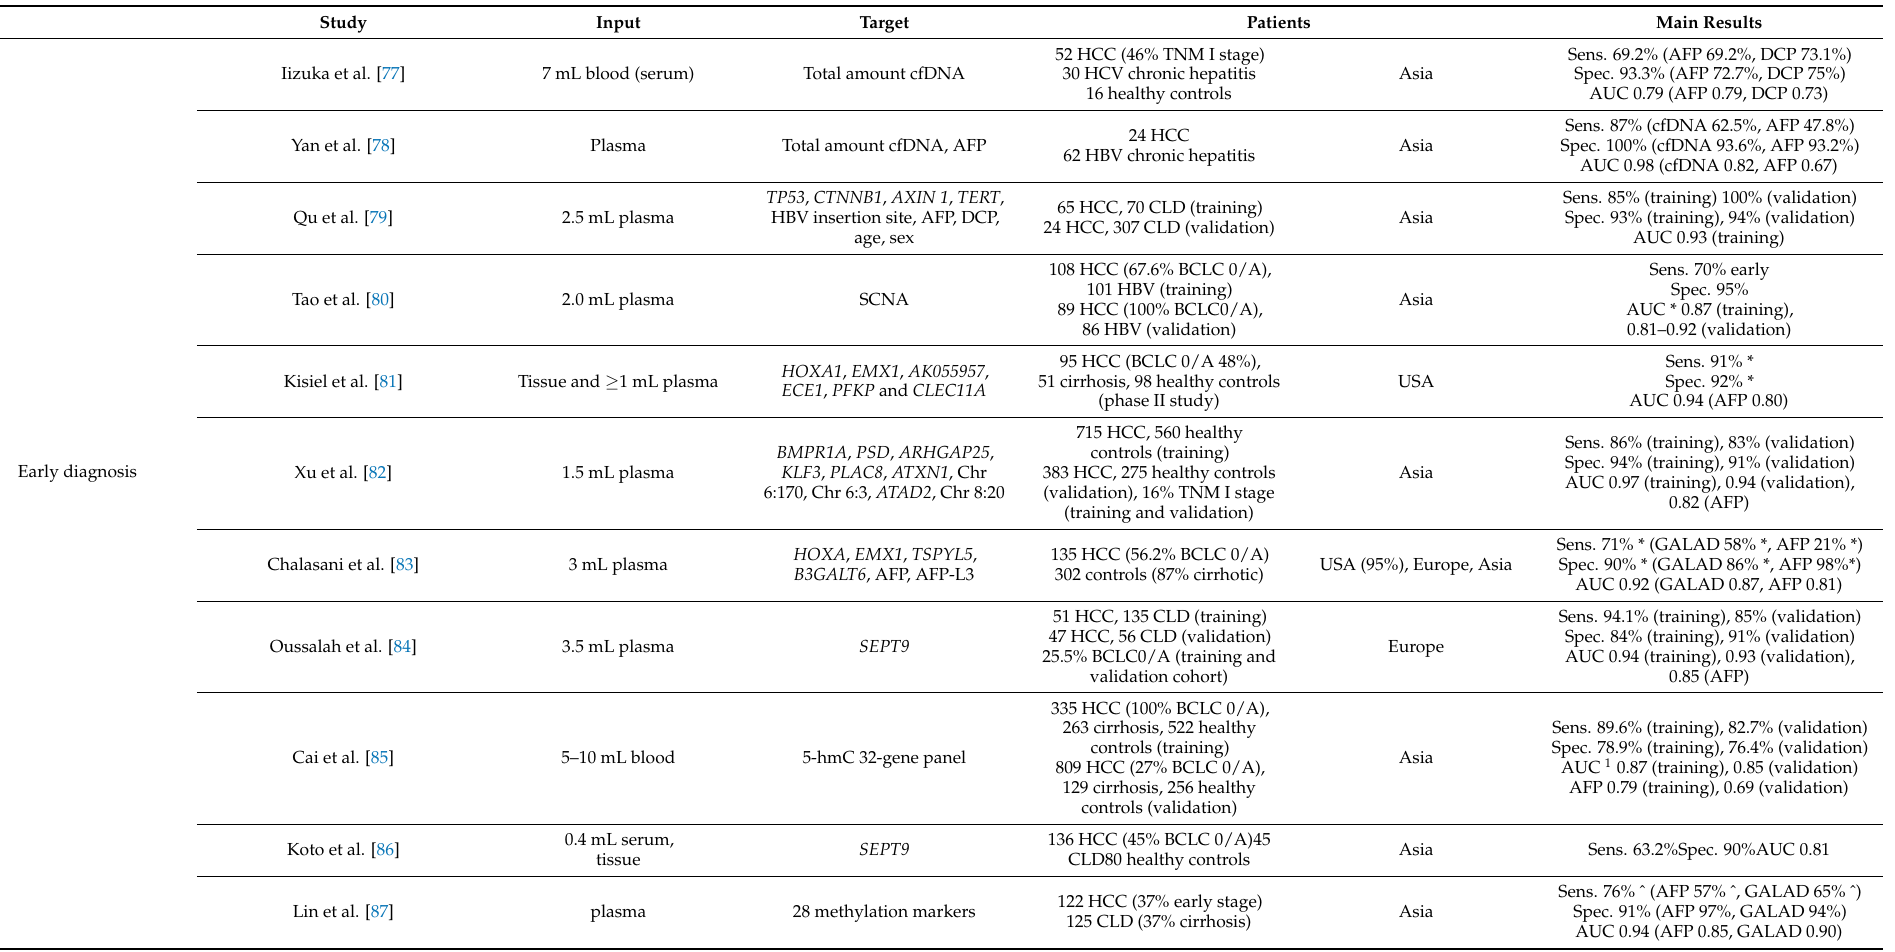
Table 1. Major studies describing the role of ctDNA in early diagnosis, predicting prognosis and monitoring systemic treatment in